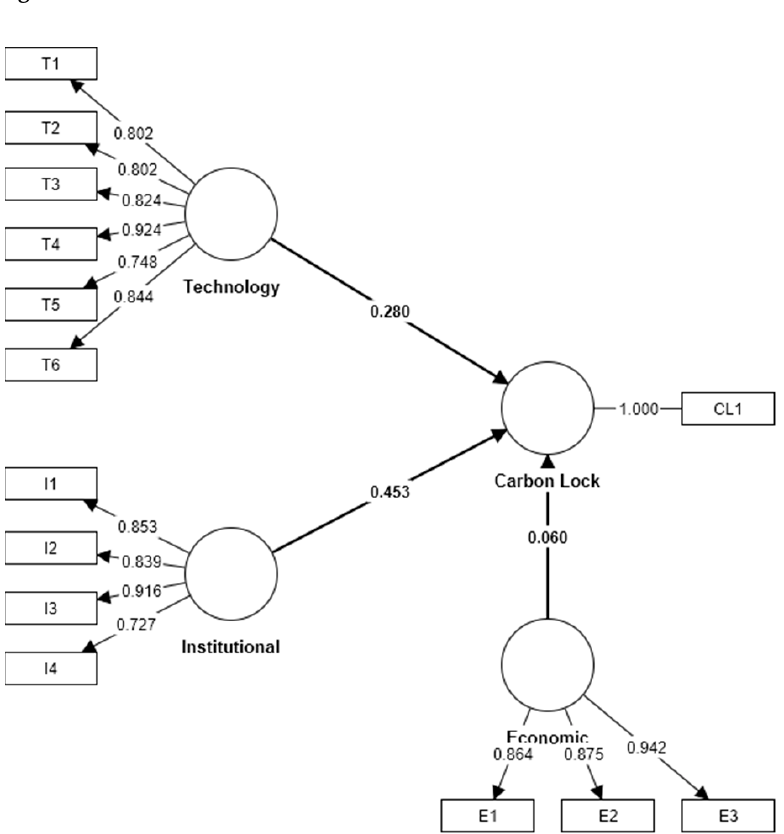
Figure 3. Results of the calculations.